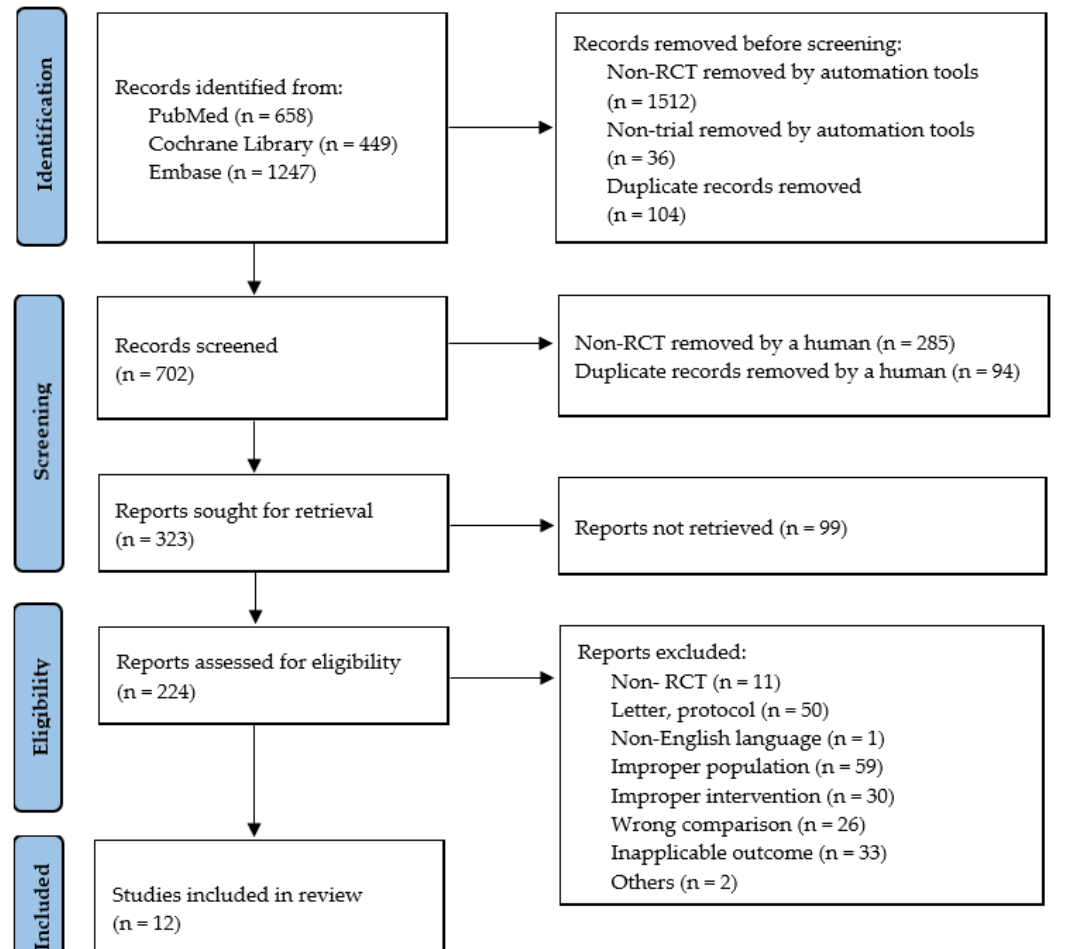
Figure 1. Flow diagram of literature search.